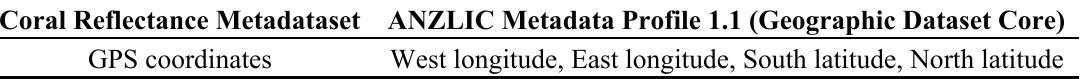
Table A9. Mappings from ANZLIC Metadata Profile 1.1 (Geographic dataset core) to the underwater benthic reflectance metadataset.